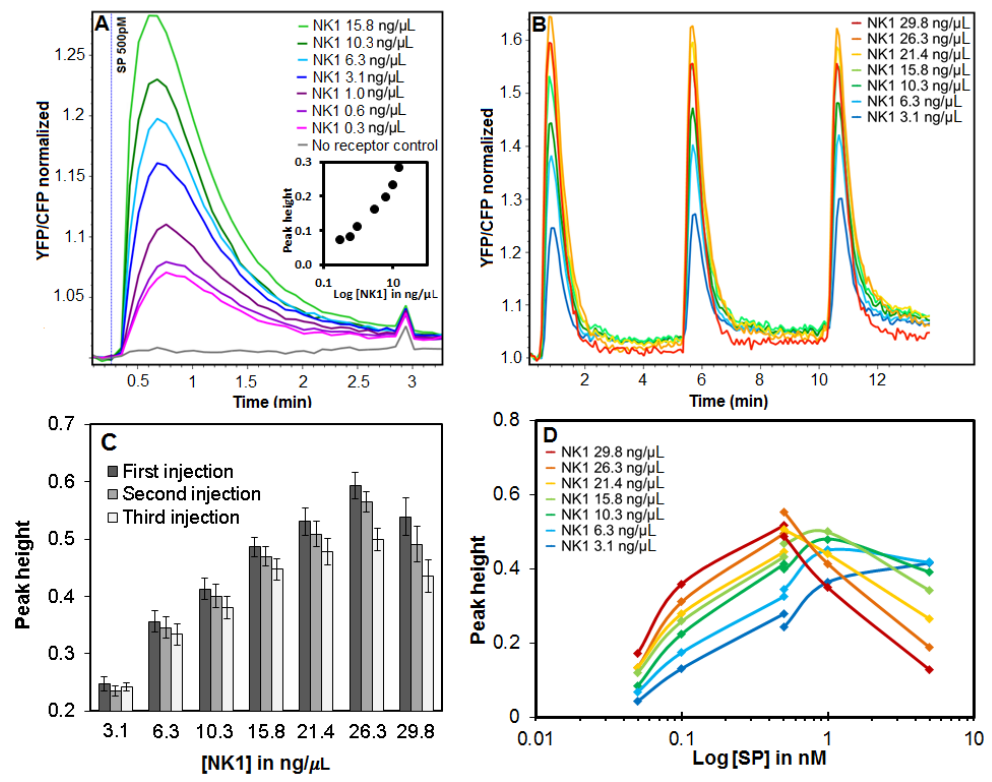
Figure 4. Calcium ion dynamics after substance P (SP) exposure to arrays co-transfected with the NK1 receptor and YC3.6 calcium sensor. Calcium ion dynamics are displayed in the YFP/CFP signal ratio obtained from the YC3.6 calcium sensor and normalized by dividing the CFP and YFP signals by the average of the first images before sample exposure. ( A ) Cytosolic calcium ion transients after 500 pM SP exposure rise with increasing NK1 plasmid DNA concentration ranging from 0.3 ng/µL–15.8 ng/µL, while total DNA concentration was kept at 33.3 ng/µL. The inset chart shows a correlation between NK1 plasmid DNA concentration and peak height. ( B ) Repeated injections of 500 pM SP on an array with a total DNA concentration of 33.3 ng/µL and NK1 plasmid DNA concentration ranging from 3.1 ng/µL–29.8 ng/µL. ( C ) Bar chart of (B) showing the peak height and standard error for each injection of 500 pM SP at the different NK1 plasmid DNA concentration. ( D ) Dose response curve for the NK1 receptor and SP ranging from 50 pM–5 nM SP. The curve was